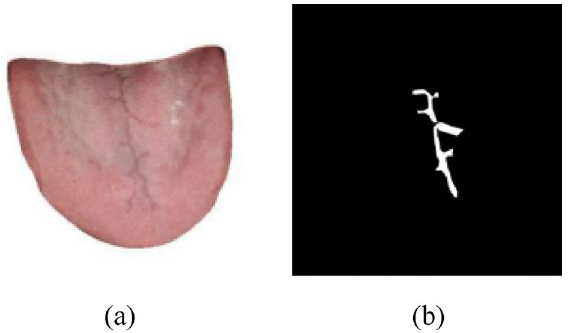
Figure 4. Tongue crack labeling effect. ( a ) Original image of cracked tongue. ( b ) Ground truth image of tongue